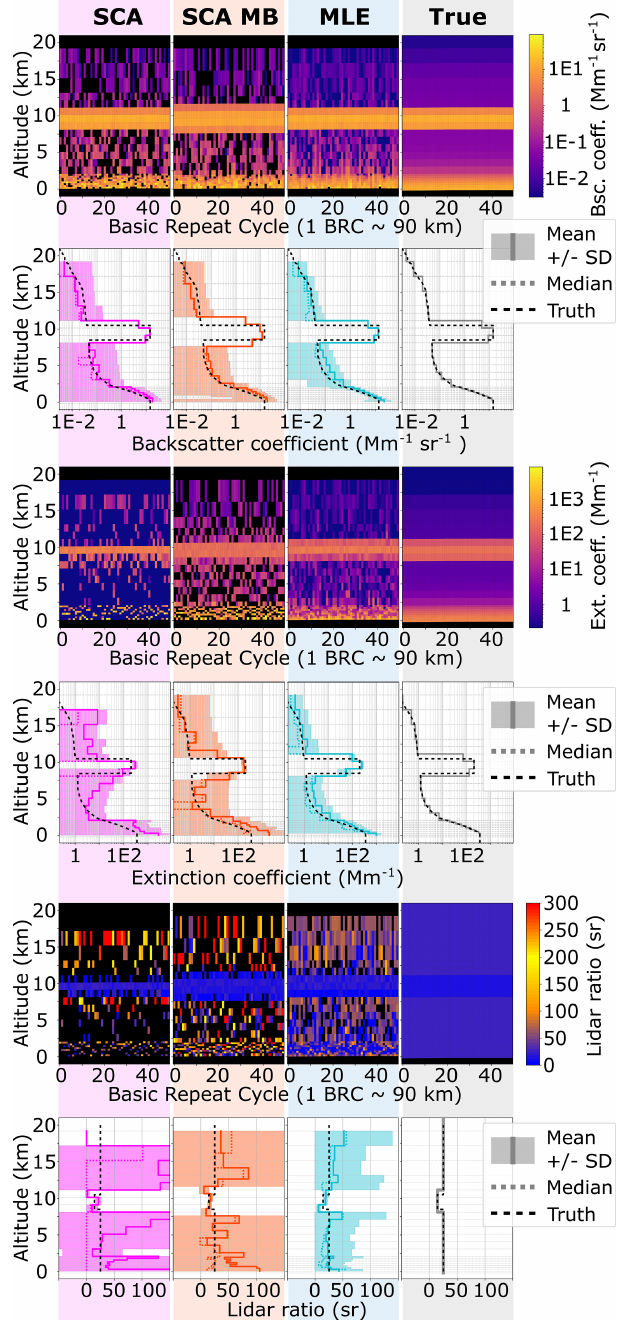
Figure 4. Simulation case II: as Fig. 2 for case I.